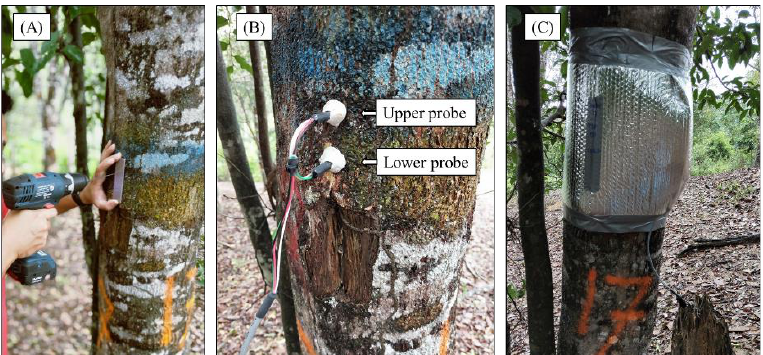
Figure 4. Sap Flow Meter Installation Set Up in Inoculated Aquilaria malaccensis Tree. ( A ) = Two small holes were appropriately drilled 5 cm above the inoculation point, ( B ) = A selection of appropriate thermal dissipation probe (TDP) was inserted into the drilled holes, ( C ) = The sensors were covered with an aluminium box and an insulating film was placed around the trunk.